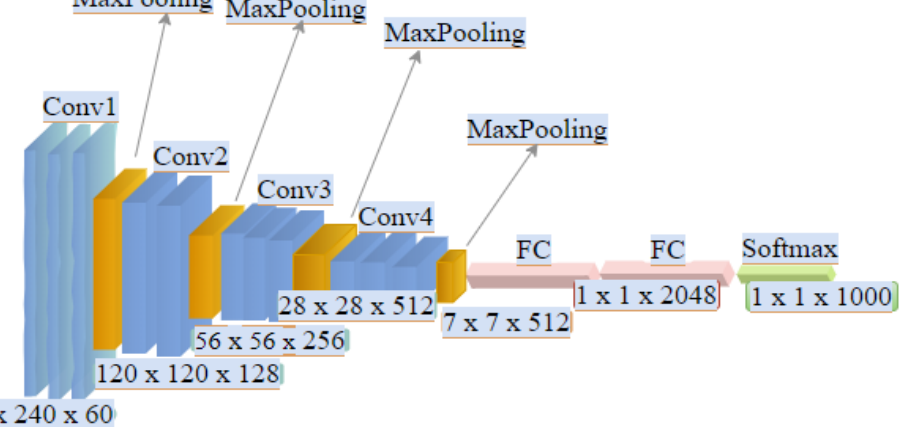
Figure 3. An Overview of the DCNN architectural incorporated onto the Ternion stream framework.